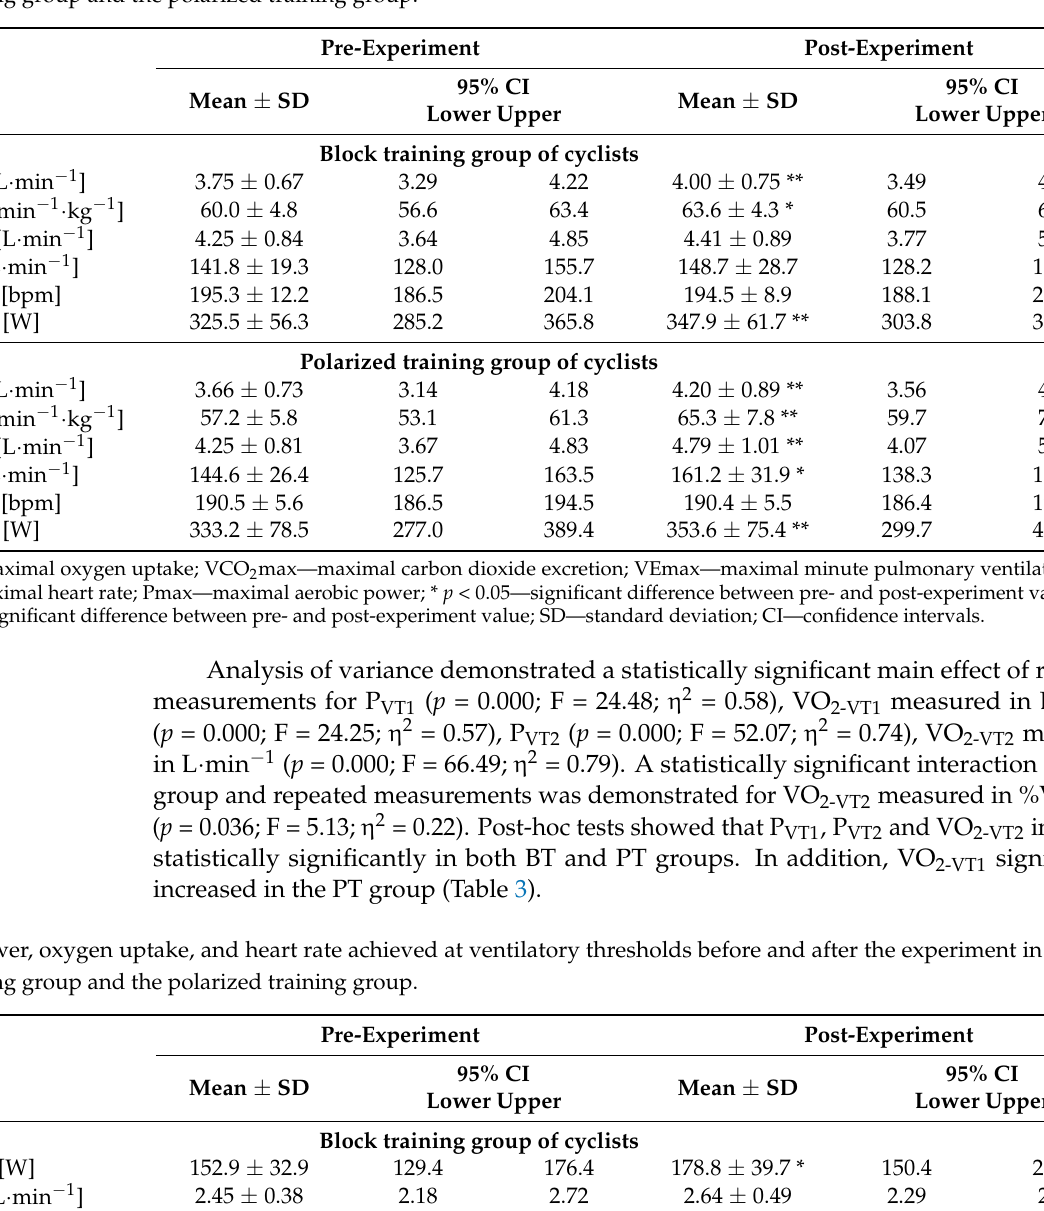
Table 2. Maximal values of respiratory parameters, heart rate, and aerobic power before and after the experiment in the block training group and the polarized training group.